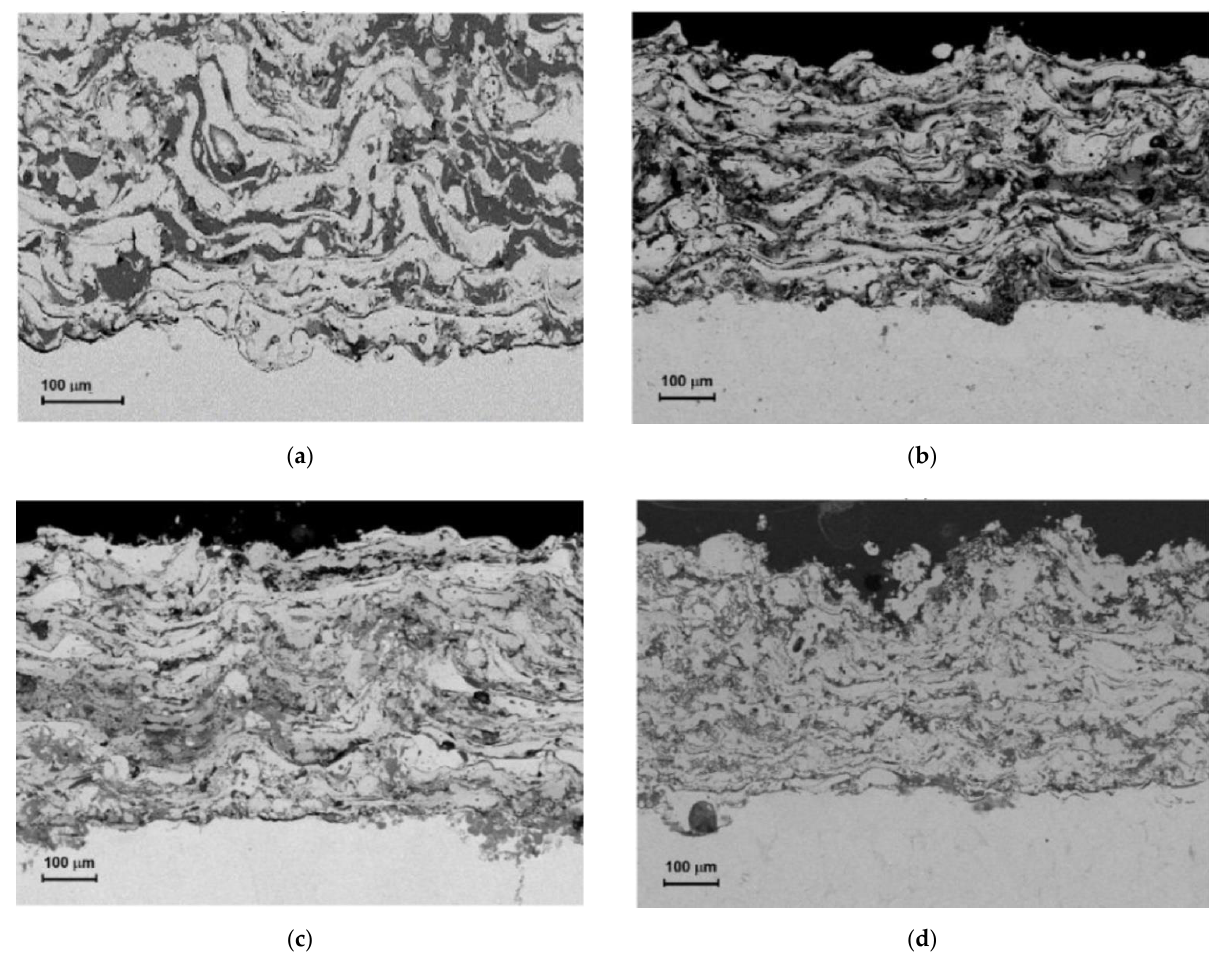
Figure 1. SEM/QBSE images of as-arc-sprayed Fe-Al-type coating ( a ), and after annealing for 2 h, at respectively: ( b ) 700 ◦ C, sample 1; ( c ) 800 C, sample 2; ( d ) 900 C, sample 3. As a result of high kinetic energy, temperature, and the speed of melted particles in the arc-spraying process, the Fe-Al-type coatings that were about 500 μm thick showed a lamellar microstructure with an inhomogeneous phases distribution where a few spheri- cal non-molten particles were visible (Figure 1a). Based on SEM/QBSE images, different shades of gray were observed for indicated phases with different atomic masses in the backscattered electron (QBSE) detector. Various shades of gray areas in the SEM/QBSE images correspond to different phases—predominant Fe(Al) solid solution with high iron is indicated by the lightest